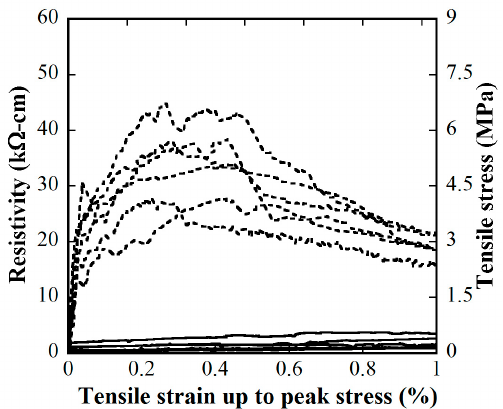
Figure 23. Electro-tensile behaviors of MSFRC2 containing MWCNTs using water, superplasticizer, NaDDBS and tributyl phosphate.